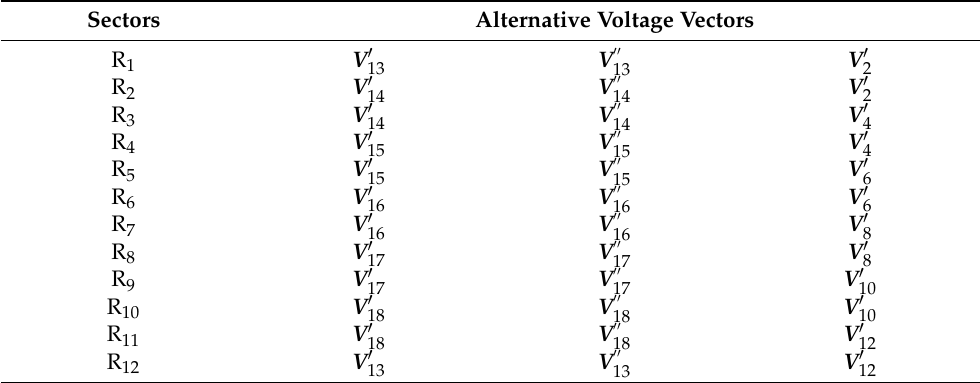
Table 4. Alternative voltage vector at region